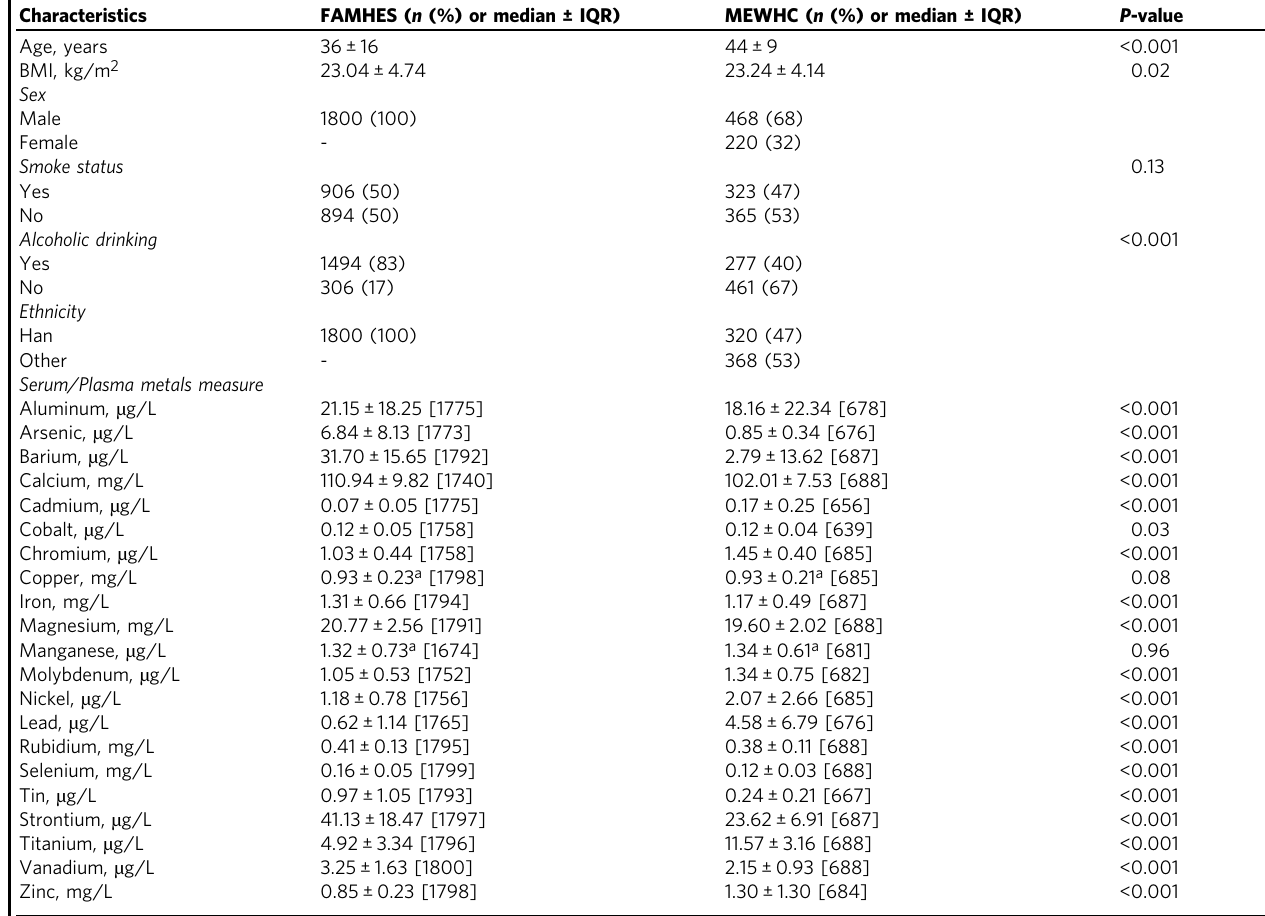
Abbreviations: FAMHES the Fangchenggang Area Male Health and Examination Survey, MEWHC the manganese-exposed workers healthy cohort, IQR inter-quartile range, BMI body mass index. Note: a Themetalconcentrationisnotstatisticallydifferentbetweenthetwocohorts;thenumberinsquarebracketsrepresentsthenumberofpeople fi